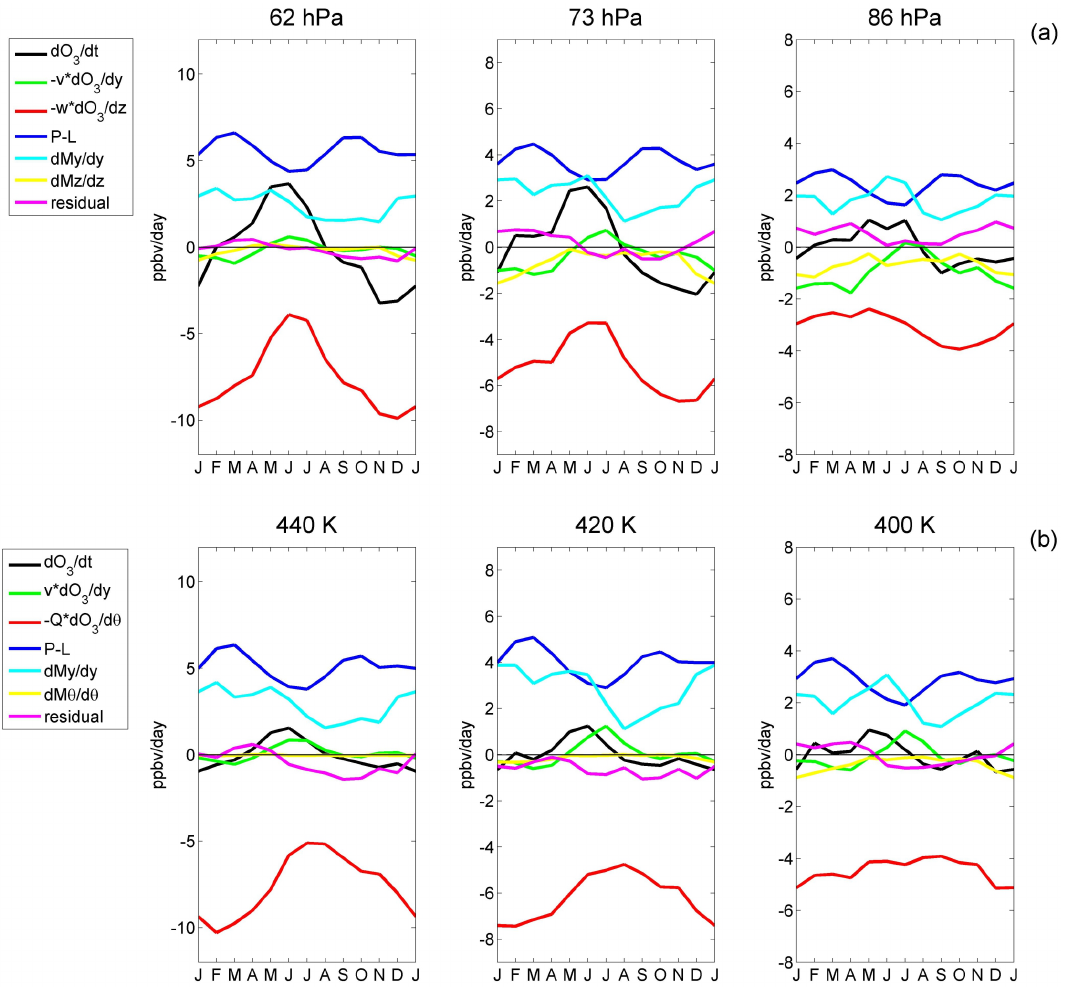
Fig. A1. Mean seasonal cycle (monthly means) of the terms in the ozone continuity equation averaged over 18 ◦ S–18 ◦ N on pressure levels (Eq. 2, a ) and isentropic levels (Eq. 6, b